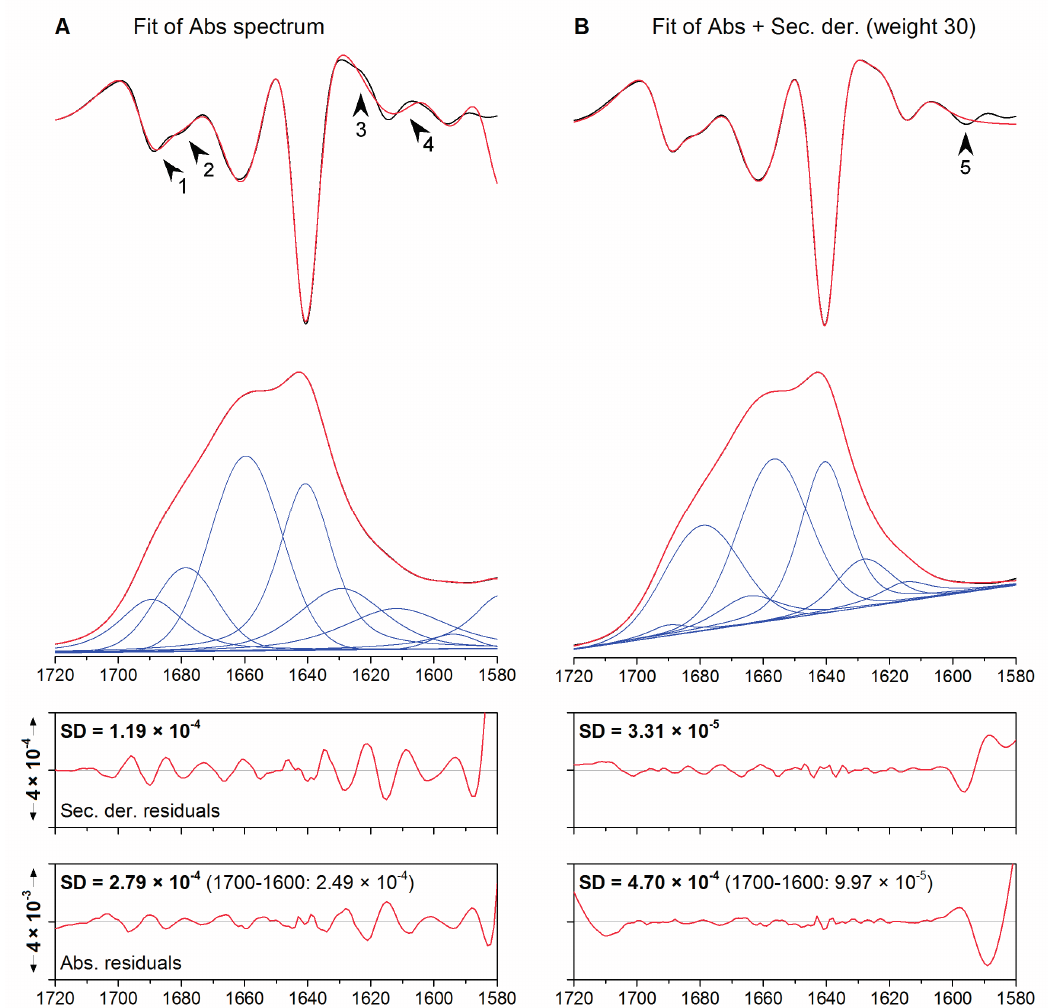
Figure 3. ( A ) Fitting of the absorption spectrum of ribonuclease A; ( B ) simultaneous fitting of the absorption and second derivative spectra ( B ) using the same set of initial spectral parameters and a weight factor of 30. From top to bottom: second derivative, absorption spectra and plots of the residuals. Original spectra are shown black, fitted spectra in red. The individual bands are shown in blue. Arrow heads denote noteworthy discrepancies between the experimental and fitted